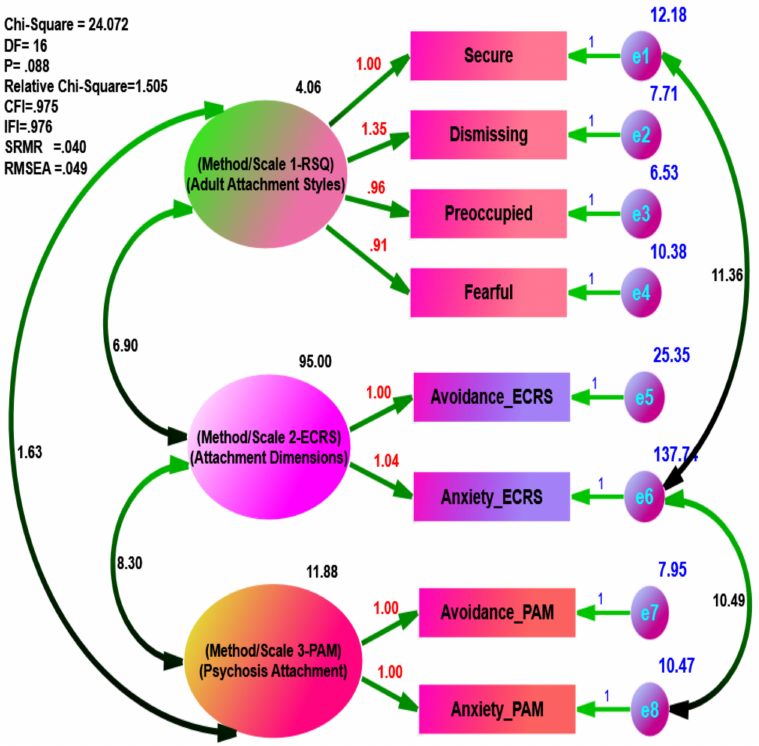
Figure 3. Multi-Methods of Hypothesized Measurement Models of the Attachment Theory in Psychiatric Sample.